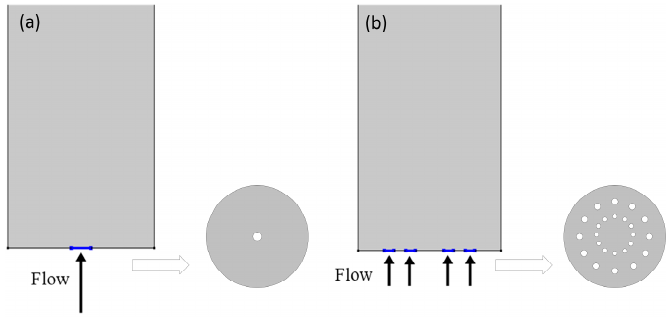
Figure 15. Schematics of inflow type at the inlet of the adsorption column: ( a ) central flow without inlet distributor; ( b ) distributed flow with inlet distributor. Nanomaterials 2017 , 7 , 195